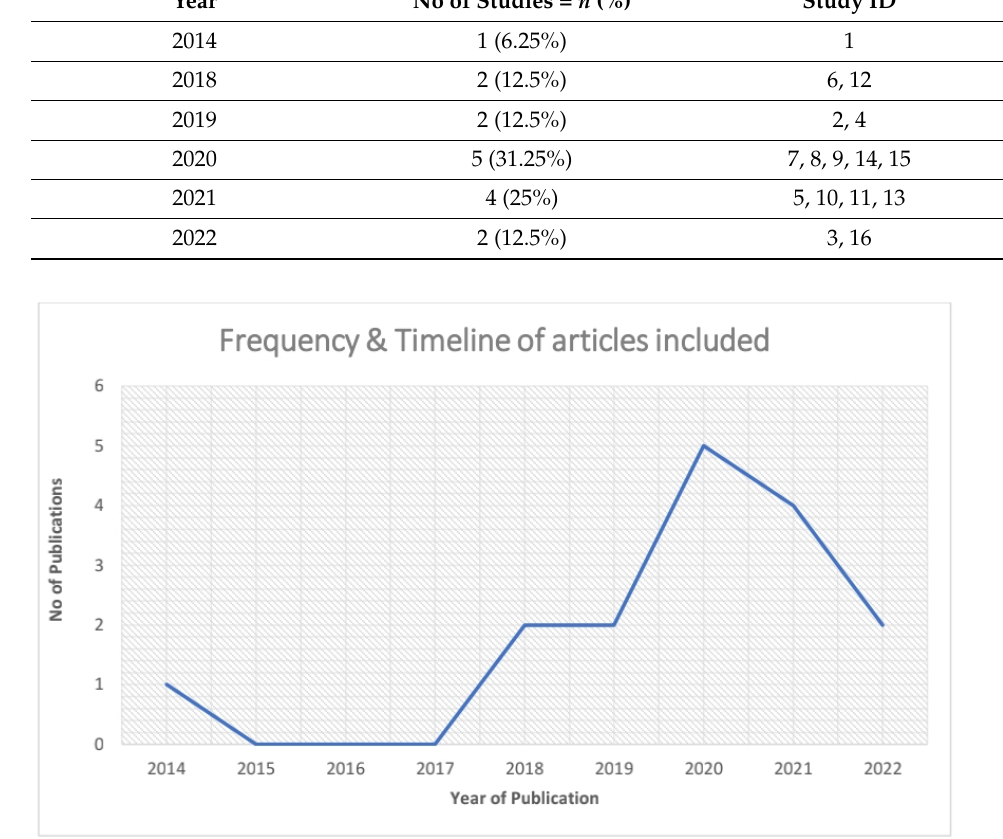
Figure 2. Depicts the Frequency & Timeline of articles that are included for this